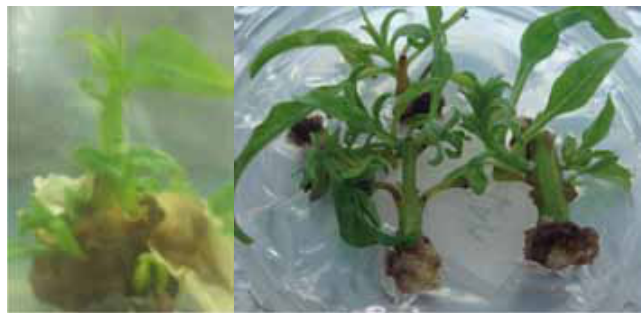
Fig. 2 - Proliferating single node explants of T. undulata in medium supplemented with TDZ (0.1 mg l -1